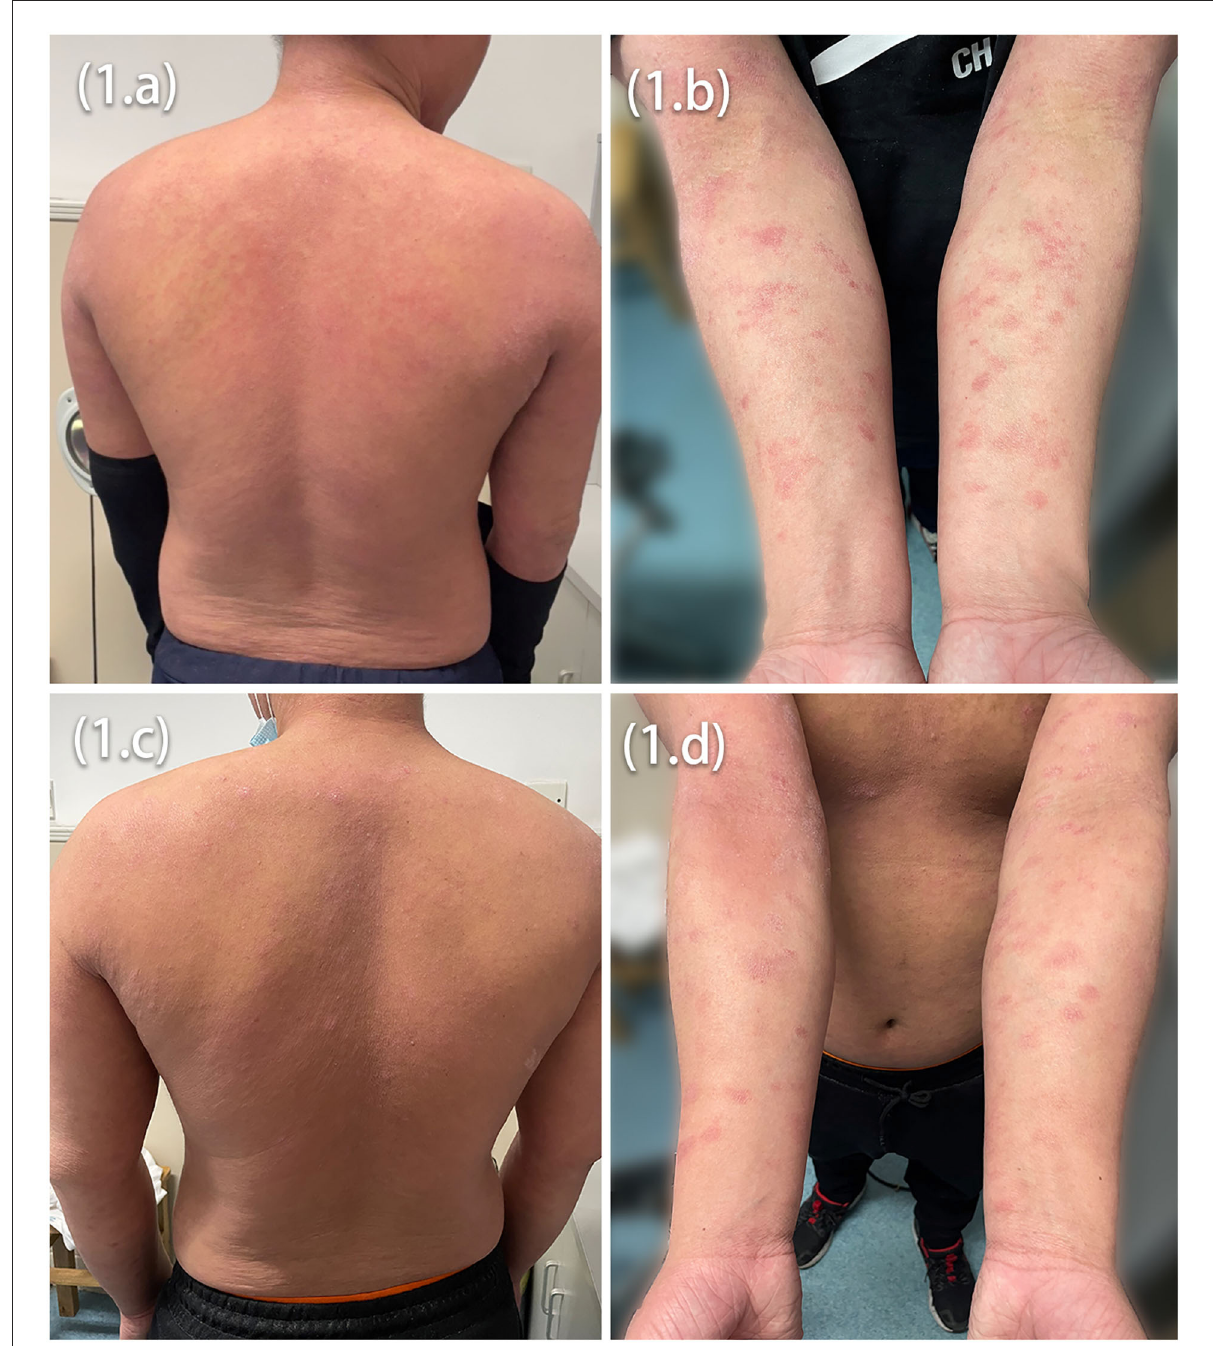
FIGURE1 Intensely pruritic, erythematic, lichenified, scaly patches on the trunk (A,C) and extensor and flexural surfaces on upper extremities (B,D) in both patients before dupilumab treatment